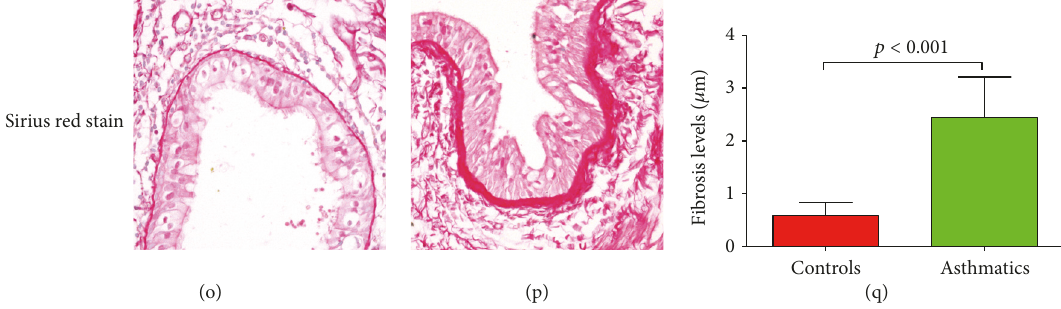
Figure 4: Staining of bronchial biopsies of both controls (postmortem samples) and asthmatics and quantitative analysis. H&E stains for (a) controls and (b) asthmatics. Expression of FSTL1 by IHC in (c) controls and (d) asthmatics and (e) quanti fi cation of FSTL1 staining. Expression of α -smooth muscle actin by IHC in (f) controls and (g) asthmatics and (h) quanti fi cation of α -smooth muscle actin staining. Expression of collagen I by IHC in (i) controls and (j) asthmatics and (k) quanti fi cation of collagen I staining. Expression of basement membrane thickness by PASM staining in (l) controls and (m) asthmatics and (n) quanti fi cation of basement membrane staining. Expression of fi brosis levels by Sirius red staining in (o) controls and (p) asthmatics and (q) quanti fi cation of fi brosis levels. Original magni fi cation × 400. Data is represented as mean ±